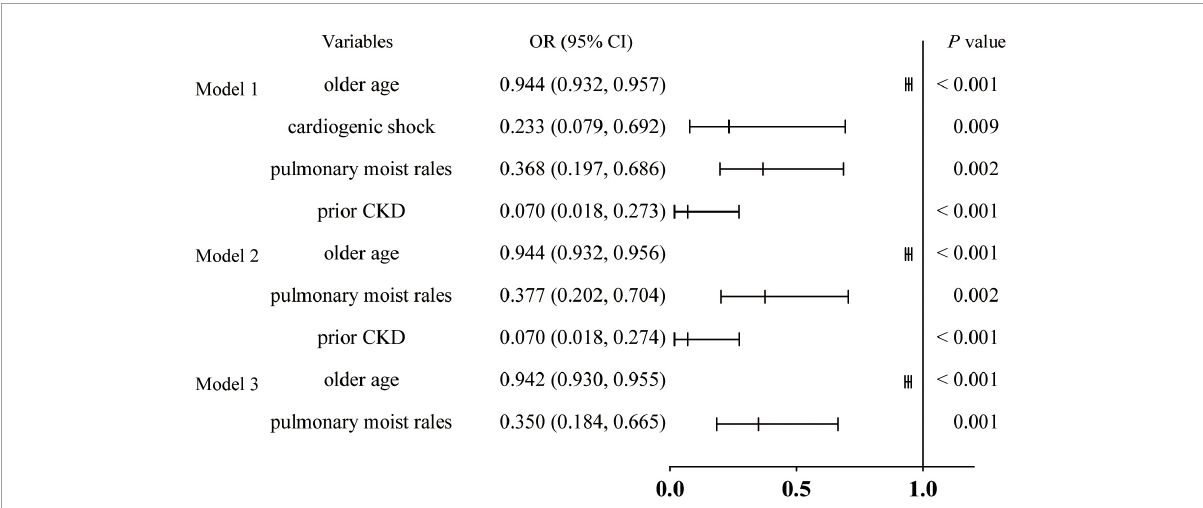
FIGURE3 Forest plot of odds ratio for risk factors of undergoing CAG. Model 1, all patients; Model 2, remove patients with cardiogenic shock; and Model 3, remove patients with cardiogenic shock and CKD; NSTEMI, non-ST segment elevation myocardial infarction; CAG, coronary angiography; OR, odds ratio; CI, conference interval; CKD, chronic kidney